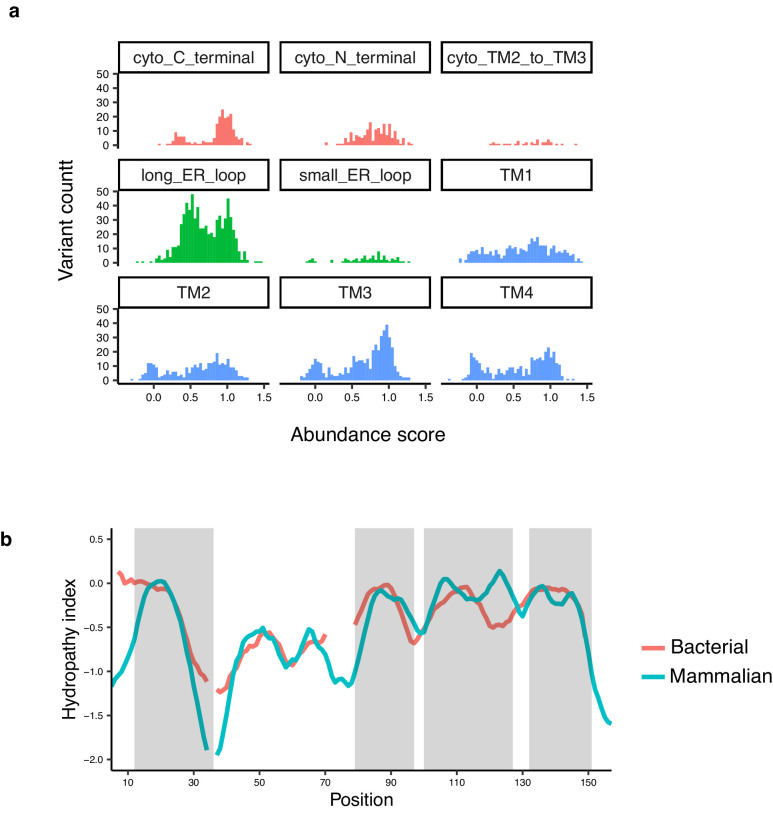
Specific domain abundance scores and hydrophobicity of bacterial and mammalian multiple sequence alignments (MSAs).(a) Histograms of abundance scores for missense variants, grouped by domain and colored by cytoplasmic, ER lumenal, or transmembrane localization. b, Hydrophobicity index of a bacterial MSA (red) and a mammalian MSA (blue), calculated using Hessa et al. scale (Hessa et al., 2005) and AlignMe server (Stamm et al., 2014).